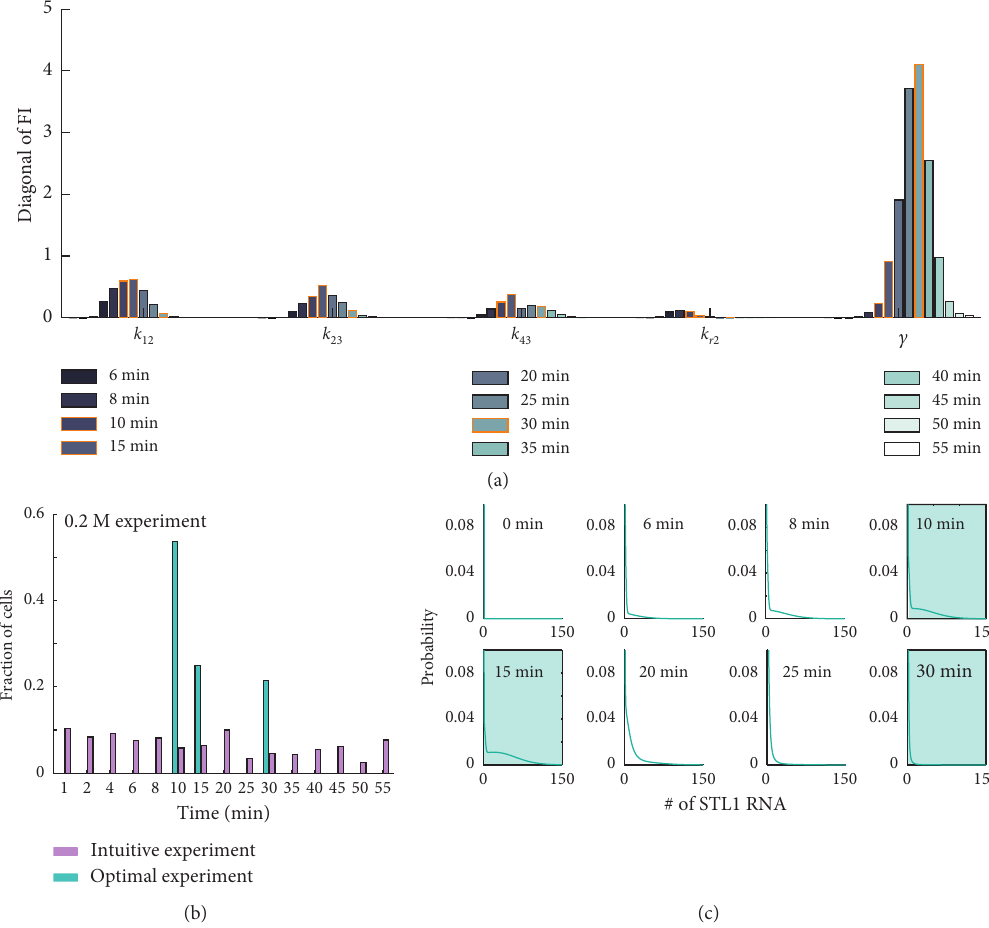
Figure 3: Optimizing the allocation of cell measurements at different time points. (a) Diagonal entries of the Fisher information at different measurement times. The optimal measurement times t � [ 10 , 15 , 30 ] minutes are highlighted in orange. (b) Comparison of optimal fractions of cells to measure (blue) at different time points determined by the FSP-FIM compared to experimentally measured numbers of cells at 0.2M NaCl (purple) from our work in [10]. (c) Probability distributions of STL 1 mRNA at several of measurement times. The blue boxes denote the time points of optimal